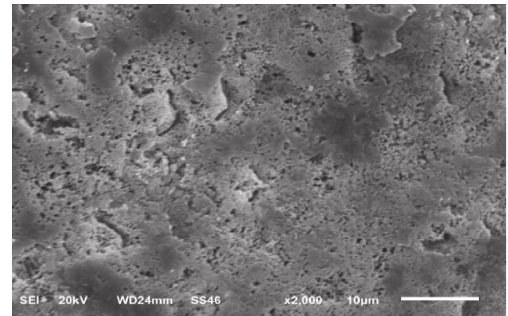
Figure 7: SEM image of the sample etched by phosphoric